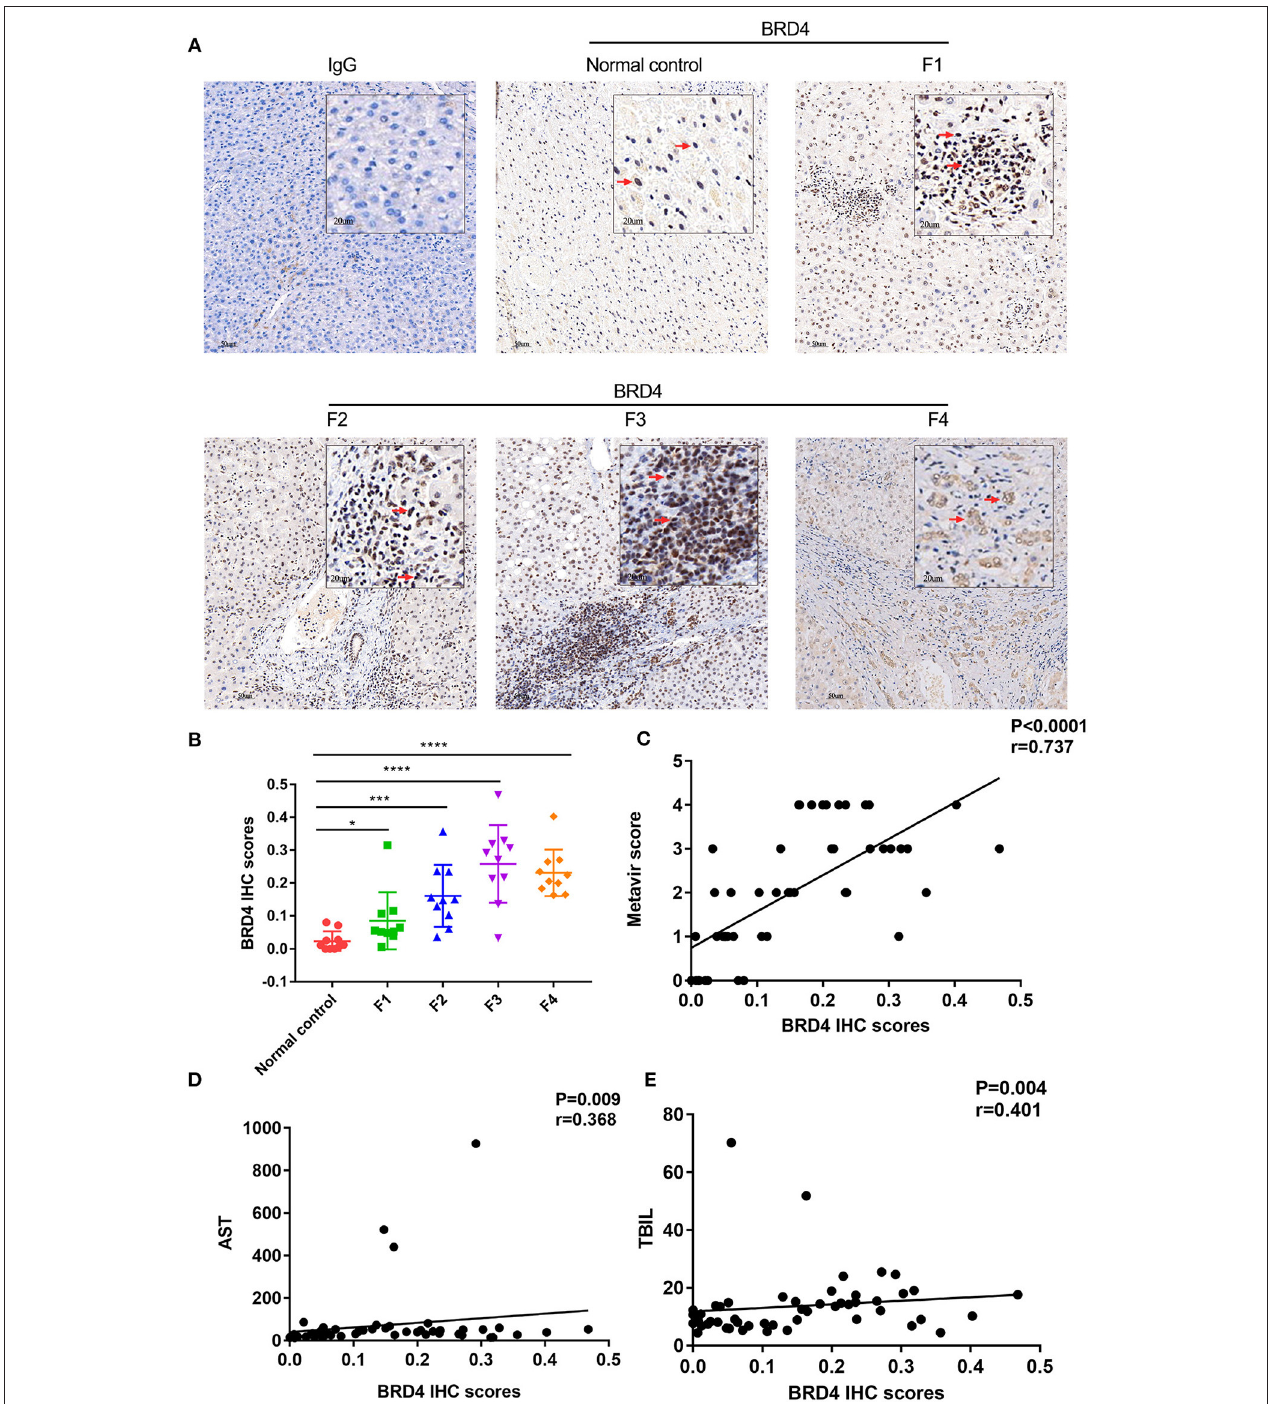
FIGURE 4 | BRD4 protein expression level in hepatic tissues of HBV liver fibrosis with different degrees. Immunohistochemistry was performed to examine hepatic BRD4 protein expression in HBV liver fibrosis with F1–F4 according to the Metavir score. The expression level of BRD4 was analysis by Image J software. (A) representative images of BRD4 expression in F1–F4 liver fibrosis. Scale bar: 50 µ m. (B) cumulative data of BRD4 expression in F1–F4 liver tissues. Data were expressed as mean ± SEM or median M (P25, P75). Differences between groups were evaluated using two independent samples t -test or Mann-Whitney U rank-sum test. (C) Spearman correlation analysis of the correlation between severity of liver fibrosis and BRD4 expression. (D) Spearman correlation analysis was conducted to assess the correlation between BRD4 expression and AST of patients with liver fibrosis. (E) Spearman correlation analysis was conducted to assess the correlation between BRD4 expression and TBIL of patients with liver fibrosis. BRD4, bromodomain-containing protein 4; HBV, hepatitis B virus; AST, aspartate aminotransferase; TBIL, total bilirubin. * P < 0.05; *** P < 0.0001; **** P < 0.00001.